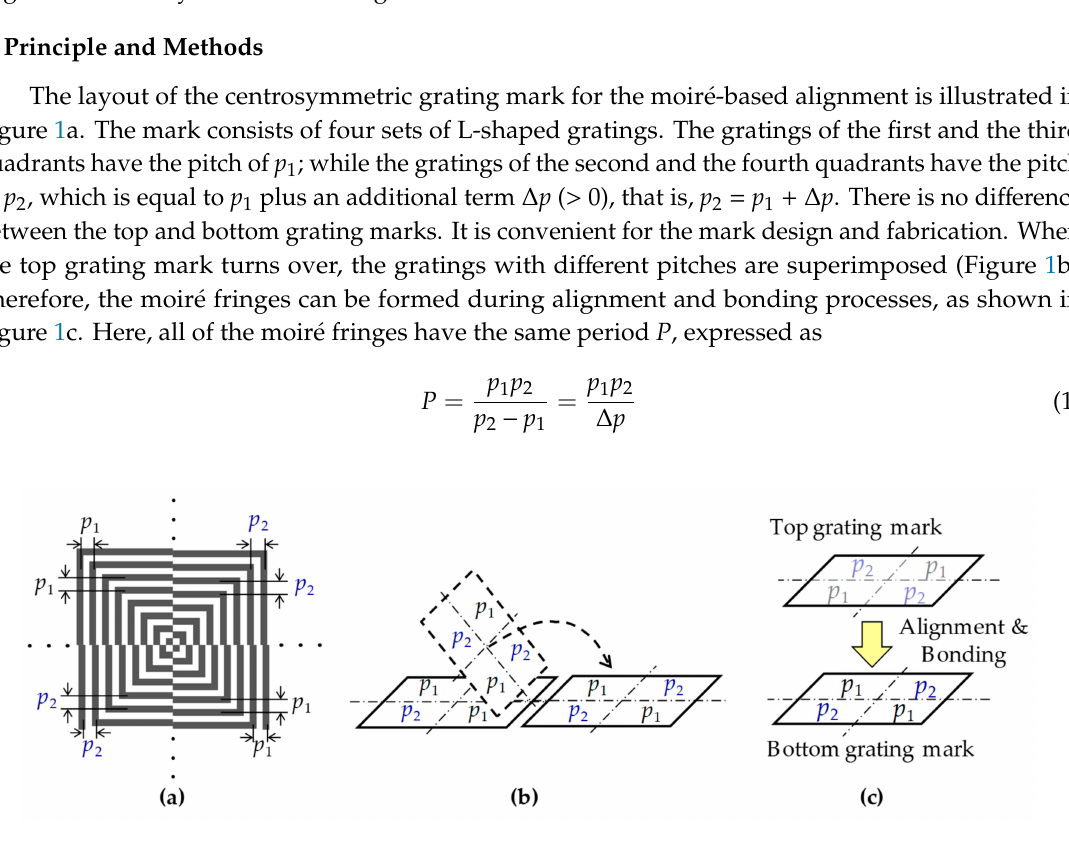
Figure 1. ( a ) Layout of the centrosymmetric grating mark for moir é -based alignment, ( b ) the top grating mark turns over and are superimposed onto the identical bottom grating mark, the moir é fringes are therefore formed during alignment and bonding processes in ( c